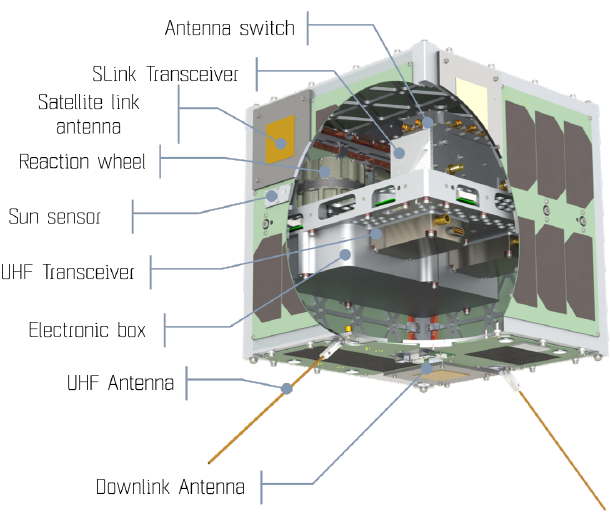
Figure 8. View of the TUBiX10 nano satellite bus.